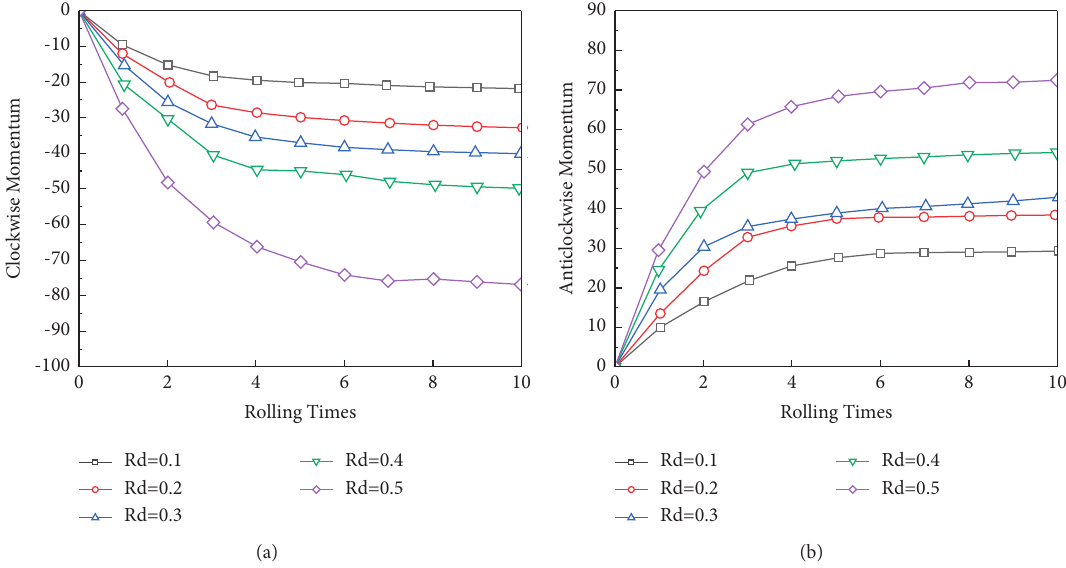
Figure 20: Particle rotation magnitude-compactor pass responses for fillings with different roundnesses. (a) Clockwise momentum; (b) rotational momentum in reverse